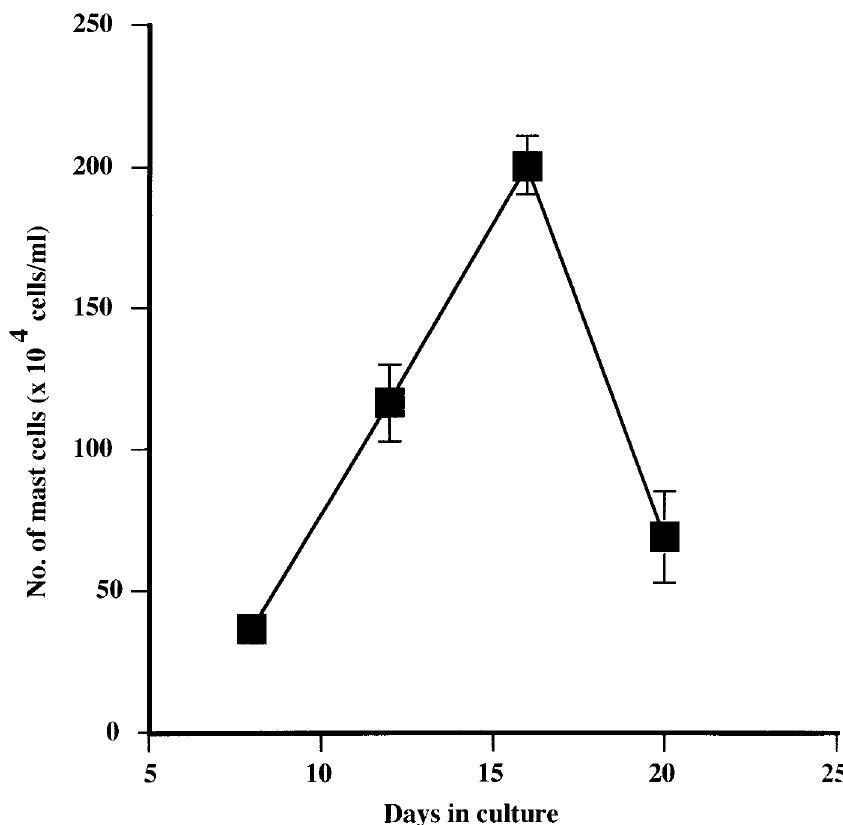
FIG. 1. Mast cell induction in cultured murine splenocytes. Spleen cells (1 ´ 10 7 cells/ml) were cultured, and the culture medium was replaced with the fresh one every 4–5 days. Mast cells were counted when the culture medium was replaced. Each point represents the mean ± SE from six determinations in triplicate